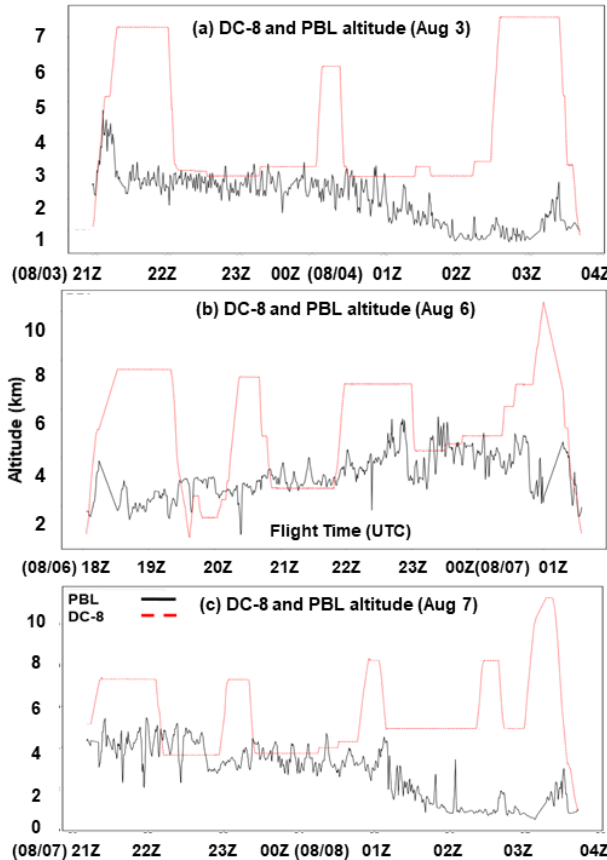
Figure 3. The DC-8 flight altitude (red) and the WRF-Chem plane- tary boundary layer height (black) for the 3 August 2019 (a) , 6 Au- gust 2019 (b) , and 7 August 2019 (c)